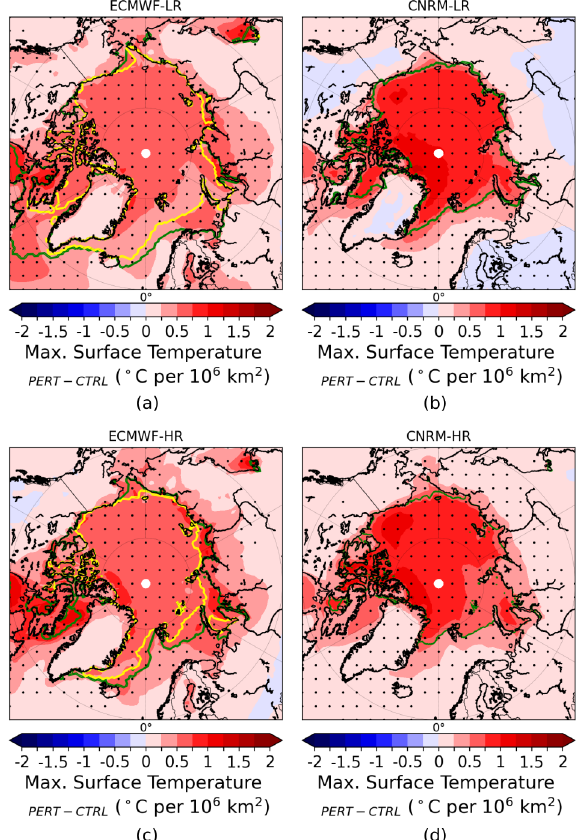
Figure 5. Ensemble mean changes (PERT − CTRL) in maximum daily surface air temperature response over the entire summer (JAS) scaled by the amount of sea ice extent loss for ECMWF-LR (a) , CNRM-LR (b) , ECMWF-HR (c) and CNRM-HR (d) . The dots show where the response is statistically significant according to a 10% level FDR test associated with a Kolmogorov–Smirnov test. The green and yellow lines represent the sea ice edge (15% ice concentration) from CTRL and PERT,